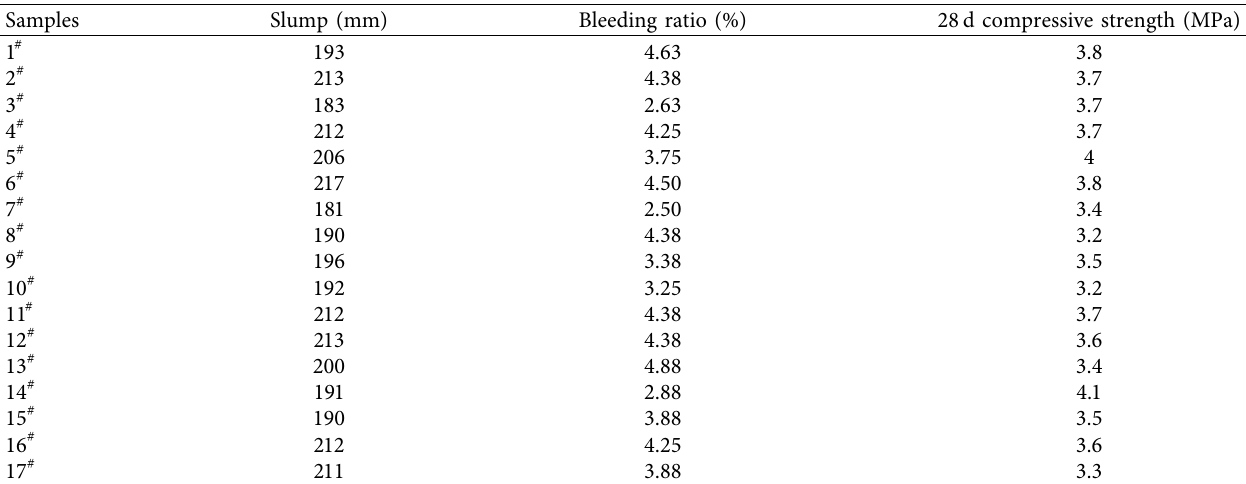
Figure 7: Photos of stress resistance test. (a) The test specimens. (b) Compressive strength measurement. Table 5: The results of